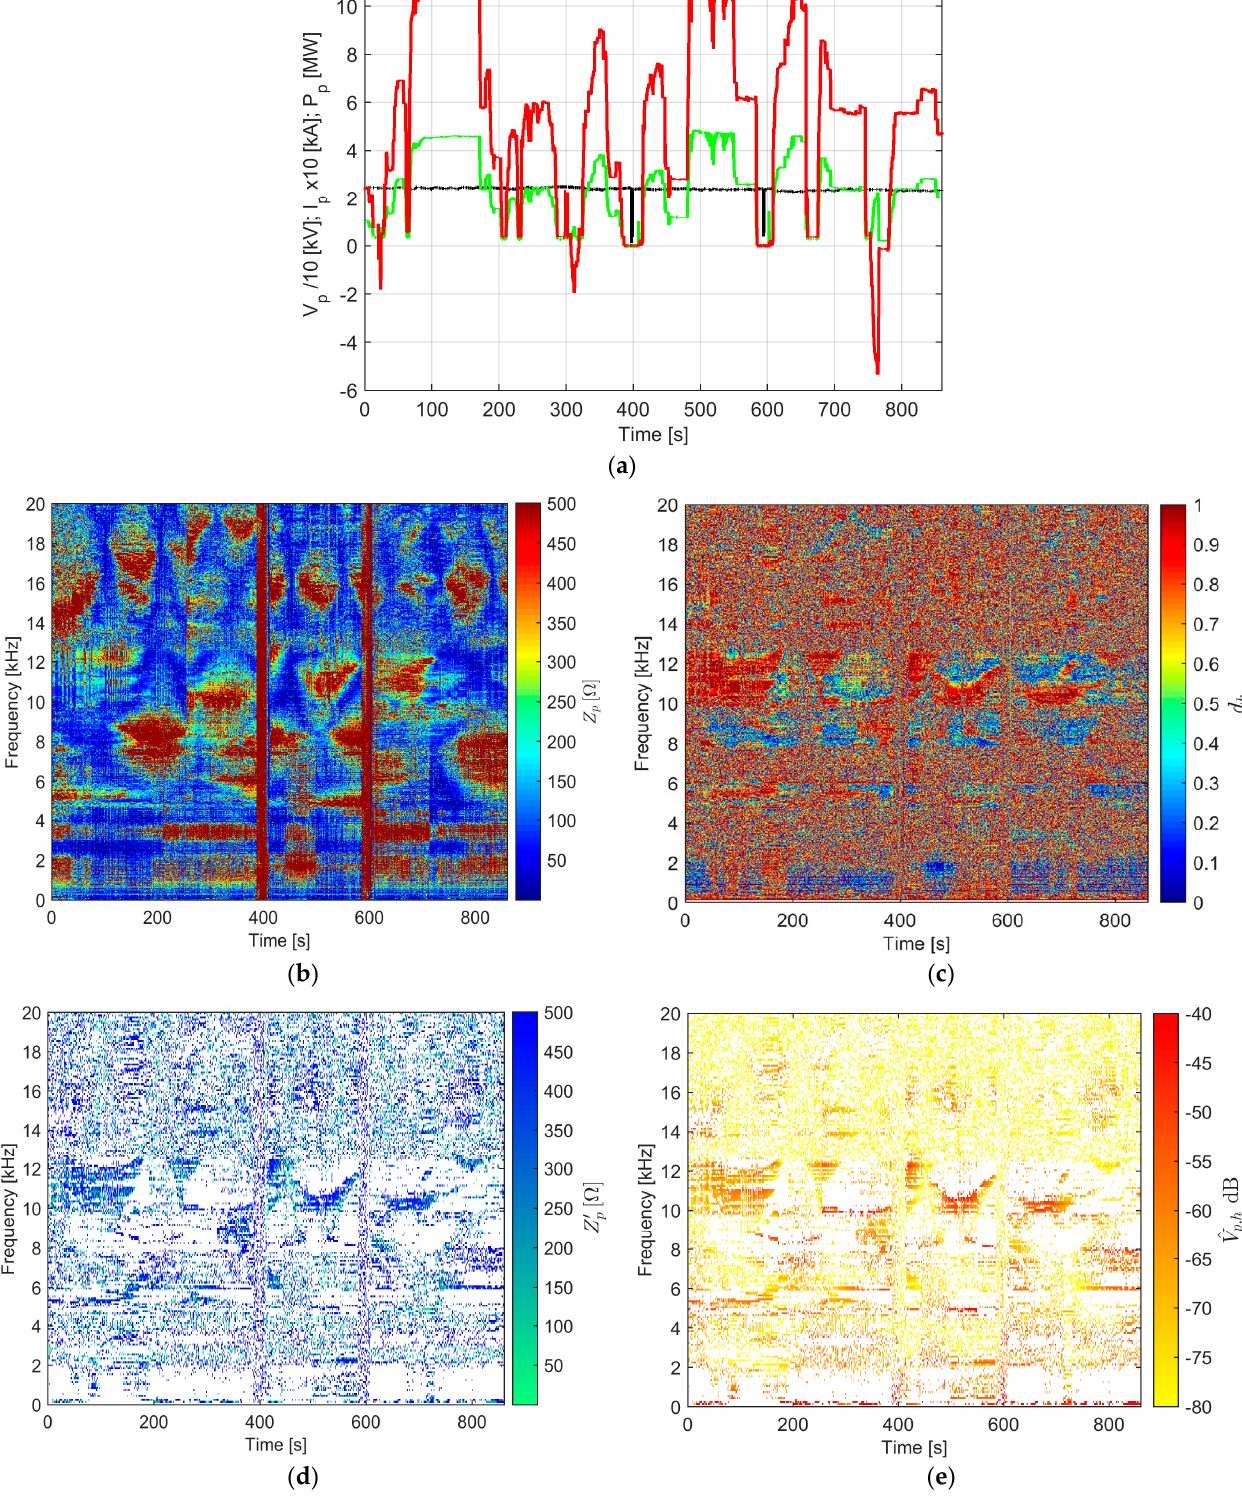
Figure 3. France example: ( a ) voltage (black), current (green), and active power (red) profiles; ( b ) harmonic impedance Z p ; ( c ) harmonic displacement factor d h ; ( d ) filtered impedance Z ′ p ; ( e ) normalized harmonic voltage ˆ V p , h